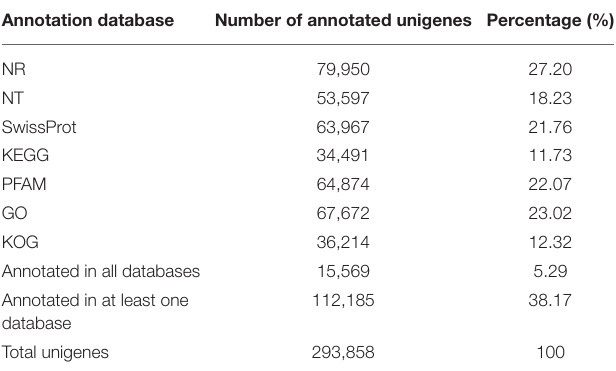
TABLE 2 | Annotation of assembled unigenes against seven public